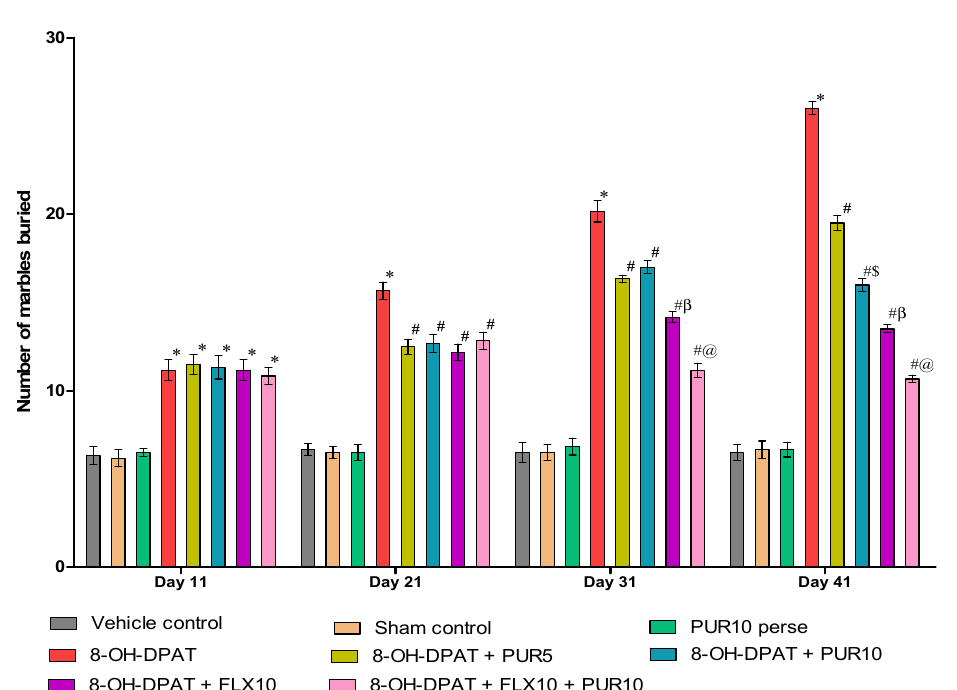
Figure 5. Effect of purmorphamine on marble-burying behavior in 8-OH OCD. Statistical analysis followed by two-way ANOVA (post-hoc Bonferroni’s test). Values expressed as mean ± SEM ( n = 6 rats per group). * p < 0.01 v/s vehicle control, sham control and PUR10 per se; # p < 0.01 v/s 8-OH-DPAT; #$ p < 0.01 v/s 8-OH-DPAT + PUR5; # β p < 0.01 v/s 8-OH-DPAT + PUR5 and 8-OH-DPAT + PUR10; #@ p < 0.01 v/s 8-OH-DPAT + FLX10.